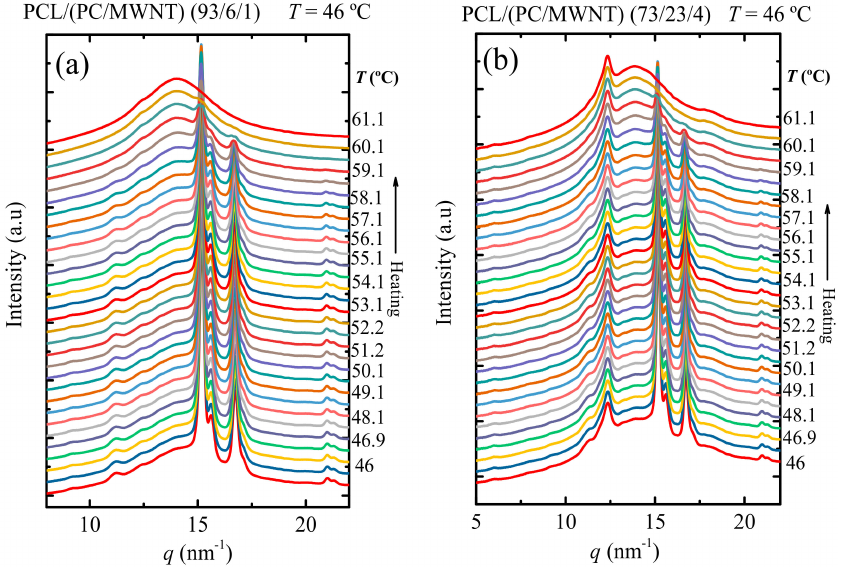
Figure 3. WAXS patterns taken during the heating at 5 ◦ C min − 1 after the isothermal step at 46 ◦ C for ( a ) PCL/(PC/MWCNTs) (93/6/1) and ( b ) PCL/(PC/MWCNTs)